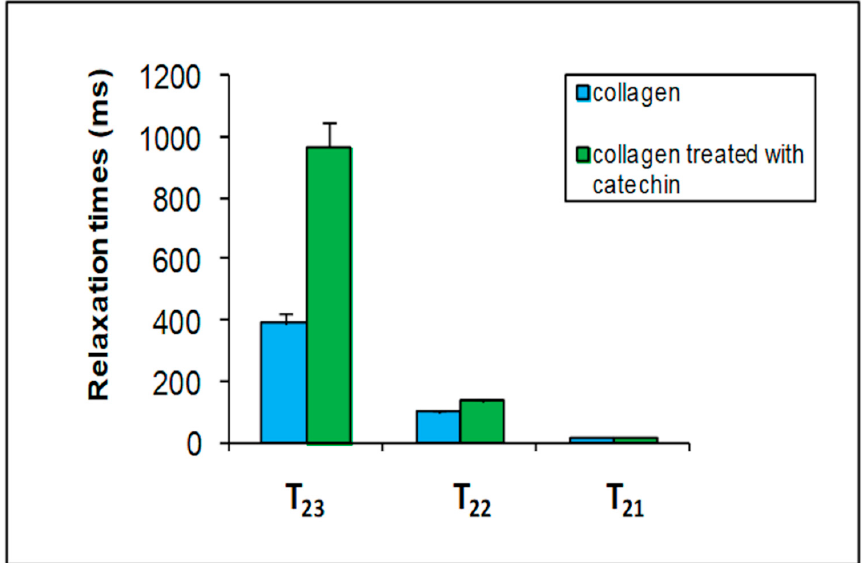
Figure 5. A comparison among the three transverse relation time (T 2 ) components of collagen (blue columns) with those of collagen modified with catechin 0.01 M (green columns).